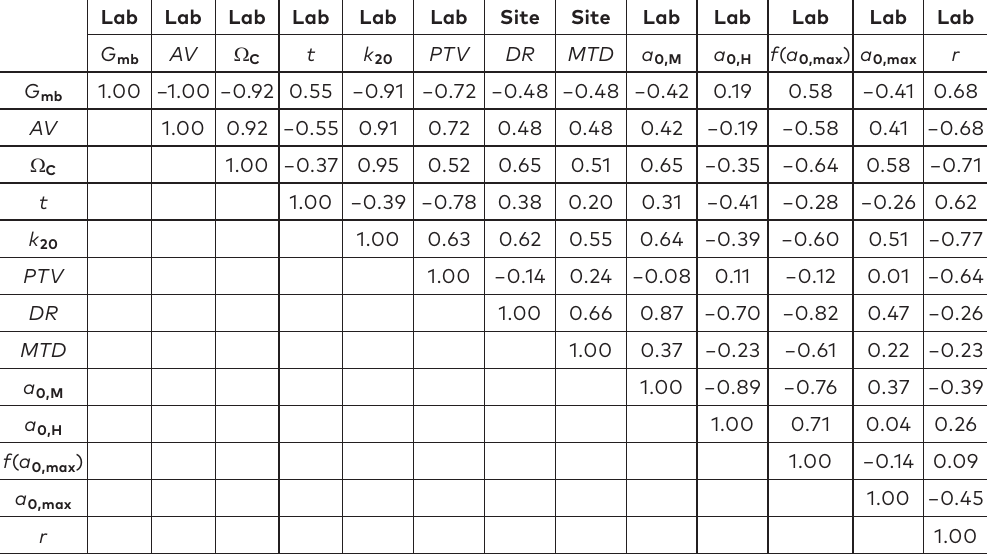
a 0,max ). ( r . (Pearson